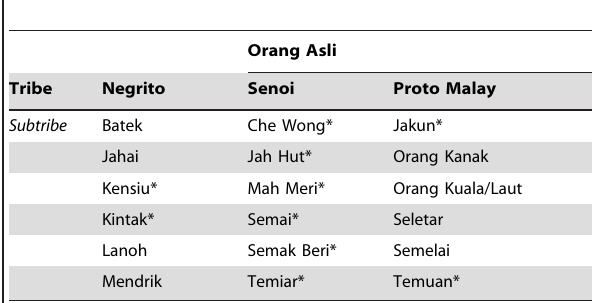
Table 1. Orang Asli classification by tribe and subtribe.